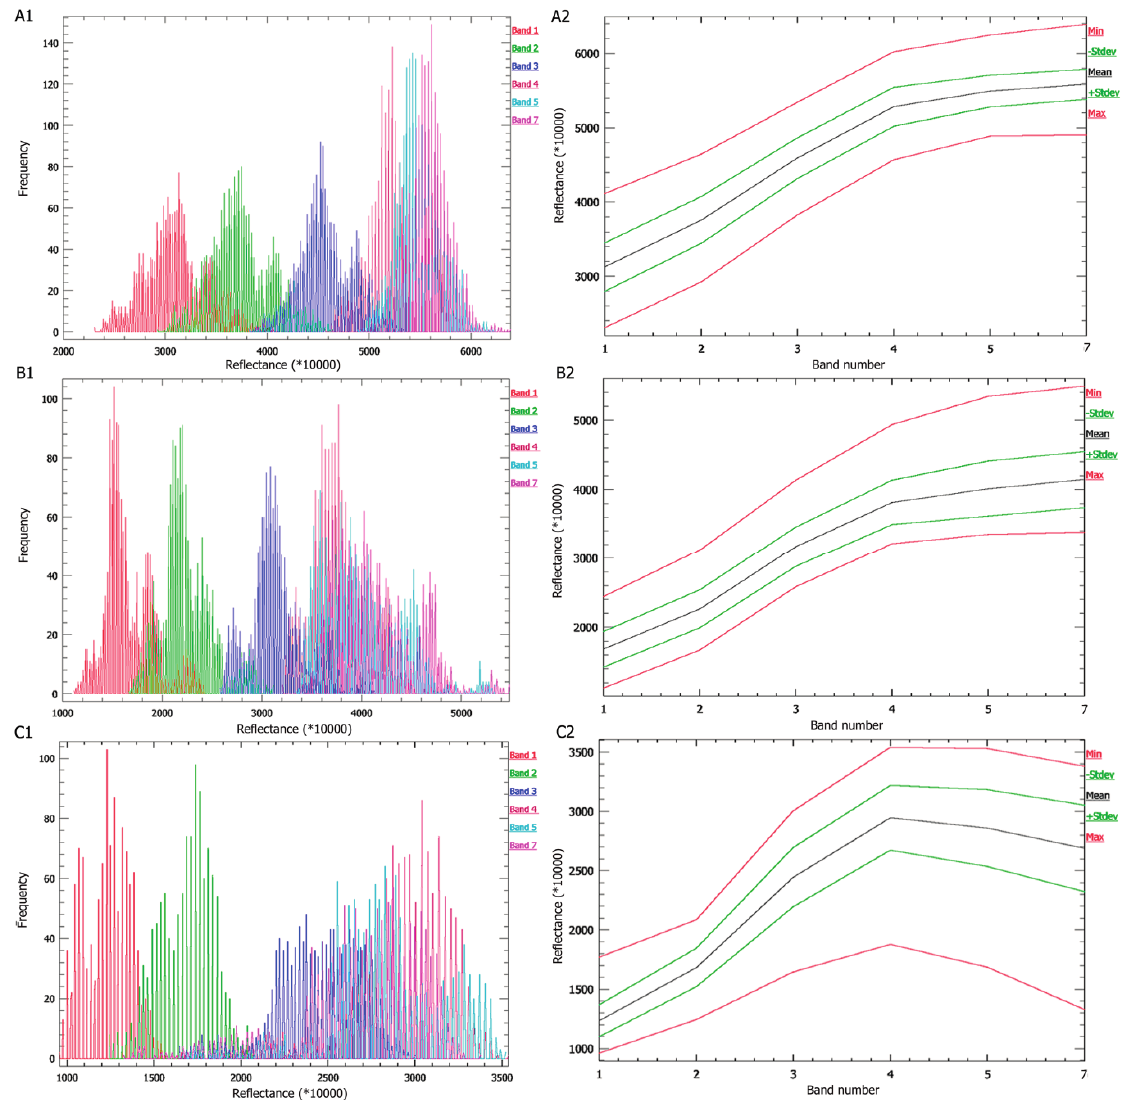
Figure 7. Statistics of the spectral library on 11 November 2012. A : Salty surface; B : Silt-rich surface; C : Clay-rich surface. Figures on the left-hand side ( A1 , B1 , C1 ) are about the histogram of training samples (greater than 1000 pixels for each class) while on the right-hand side ( A2 , B2 , C2 ) are the statistic boundary of each